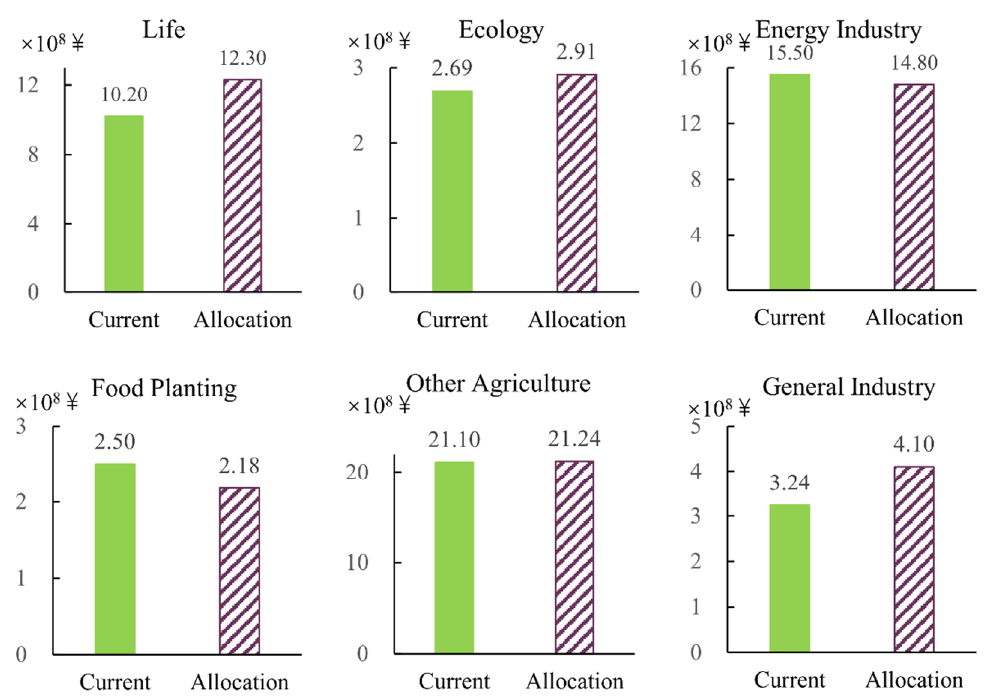
Figure 2. Comparison chart of water resources value in various industries under different water water rights.